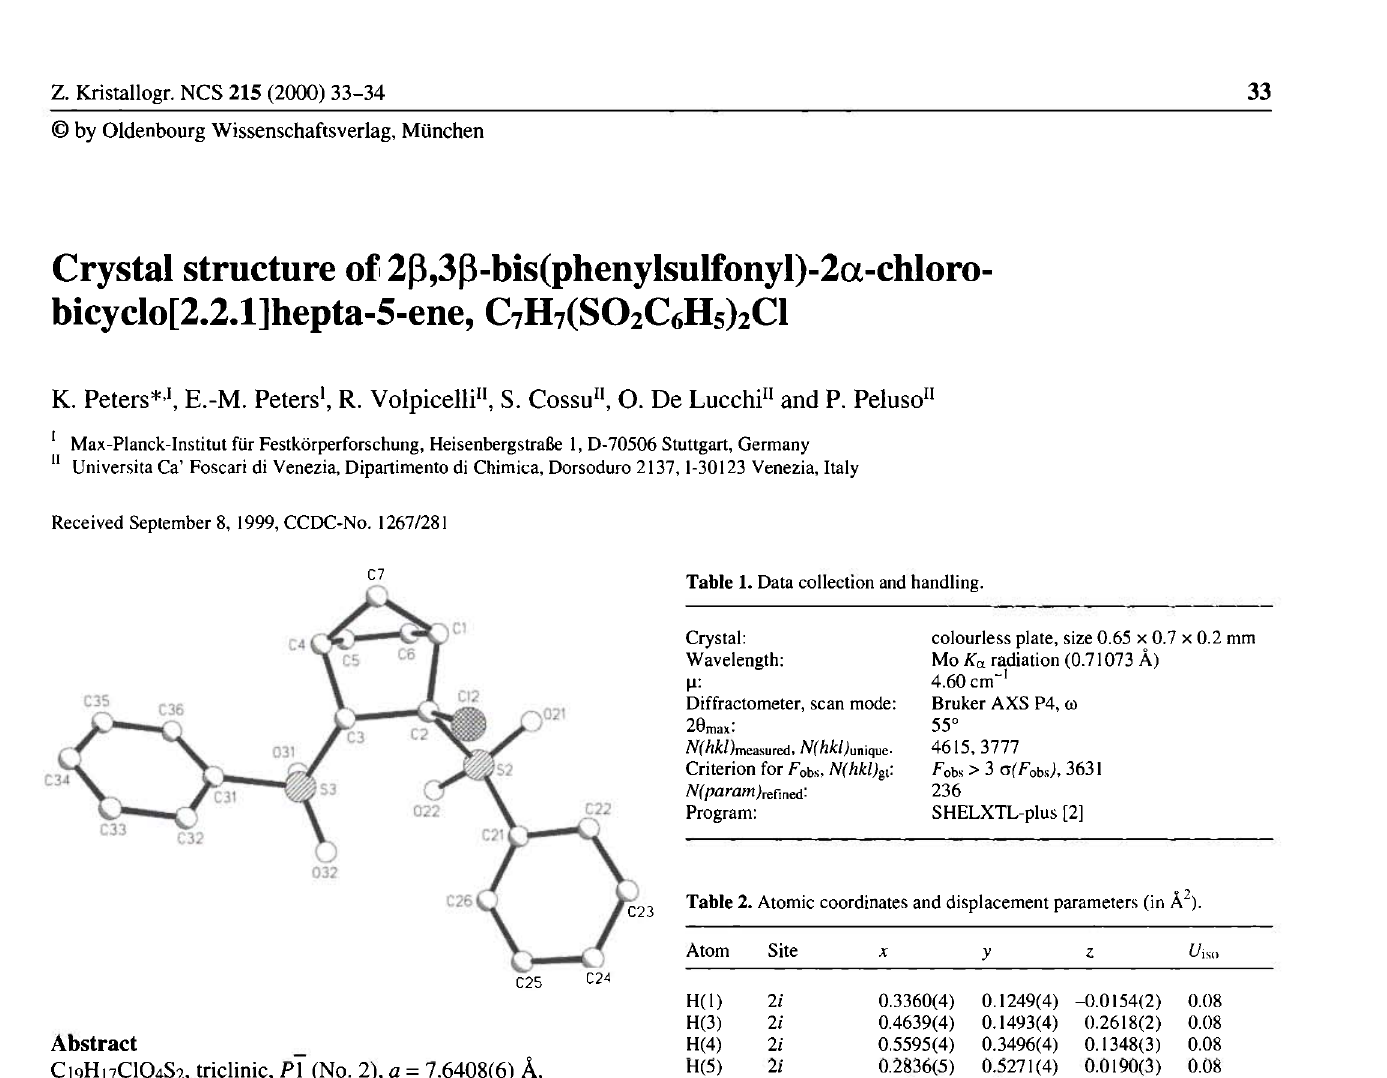
Table 2. Atomic coordinates and displacement parameters (in A 2